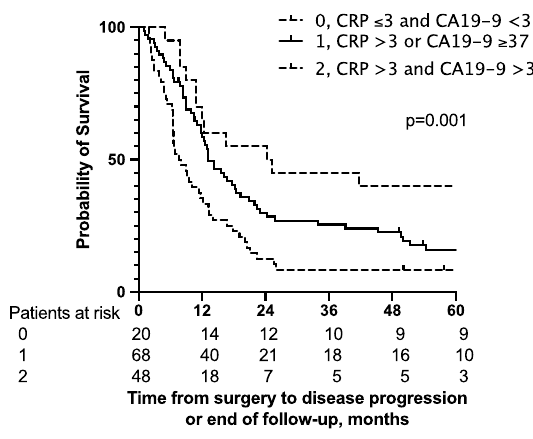
Figure 2. ( a ) Disease-free survival (DFS) for all patients according to CRP and CA19-9 levels. Median DFS were 36 m (95% CI 3–68 m), 13 m (95% CI 10–16 m), and 8 m (95% CI 6–10 m). ( b ) DFS for NAT patients according to CRP and CA19-9 levels. The median DFS were 48 m (95% CI –), 13 m (95% CI 9–18 m), and 9 m (95% CI 5–12 m). ( c ) DFS for US patients according to CRP and CA19-9 levels. The median DFS were 24 m (95% CI 5–44 m), 13 m (95% CI 9–17 m), and 8 m (95% CI 5–11